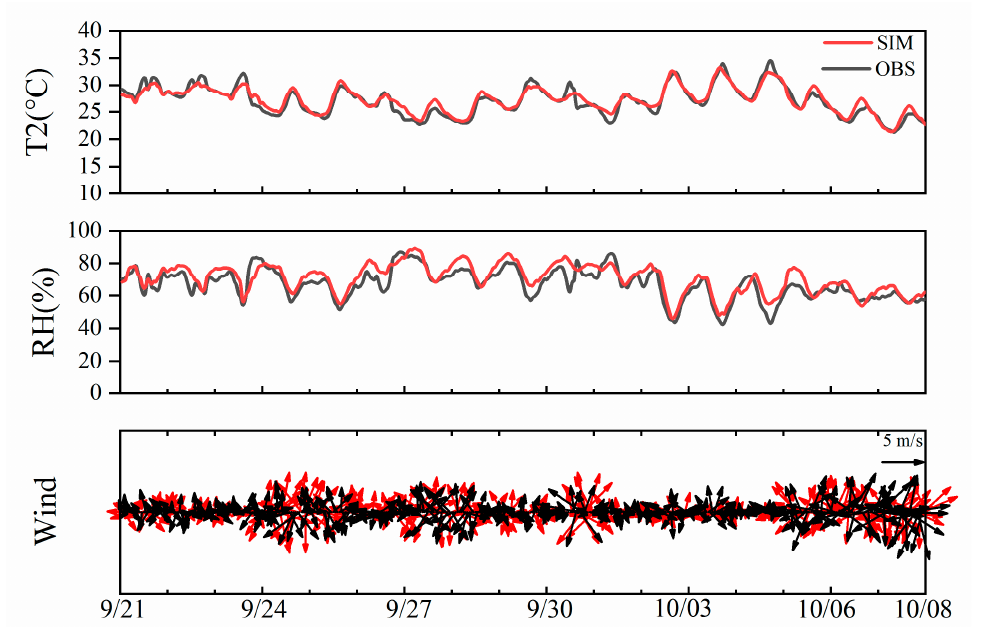
Figure 6. Time series of the WRF-Chem simulated (red; SIM) and observed (black; OBS) hourly 2 m temperature (T2), 2 m relative humidity (RH), and 10 m wind (including wind speed and wind